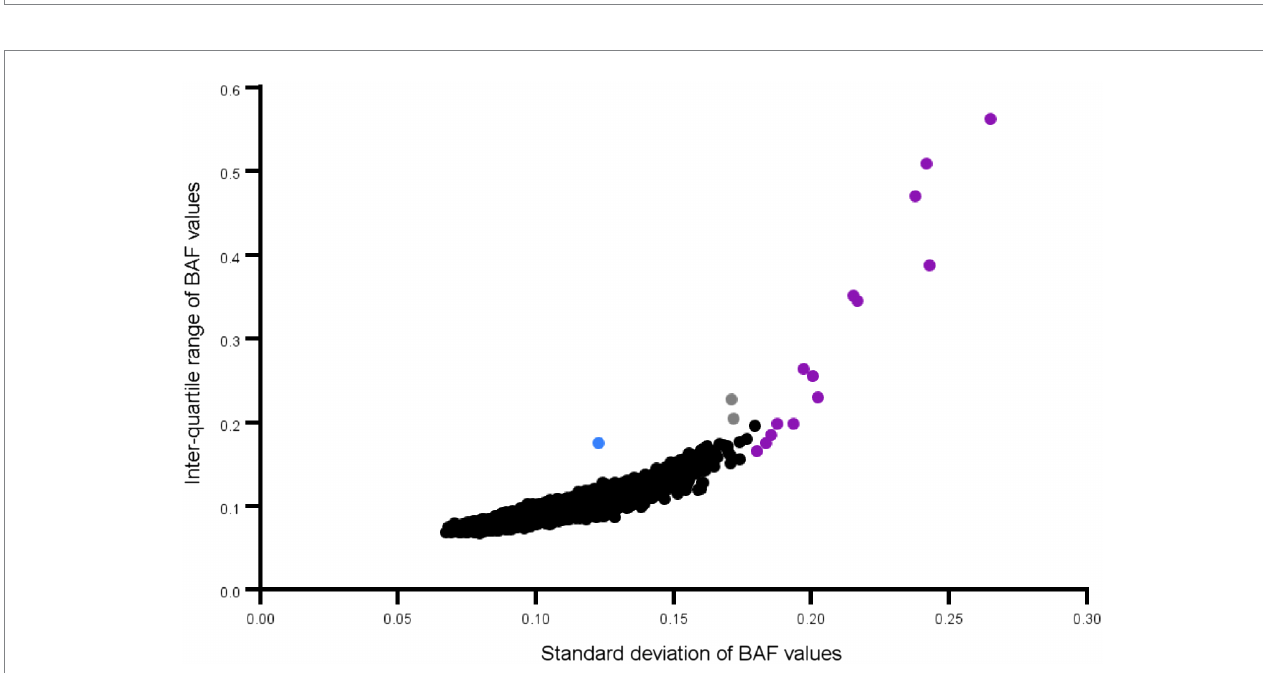
FIGURE 2 Mosaicism plot of all Saudi schizophrenia cases and controls: Each dot represents a chromosomal arm of an individual. Outliers for standard deviation and the interquartile range of the BAF values, are an effective way to screen for large mosaic events. The chr15q arm is shown in blue. The dots in purple are chromosomes where the entire arm or close to the entire arm is a long run of homozygosity. Only those B Allele Frequency (BAF) values between 0.15 and 0.85 are used in these